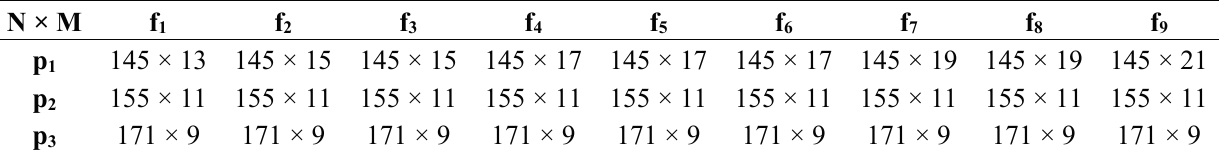
Table 3. Masked image sizes.